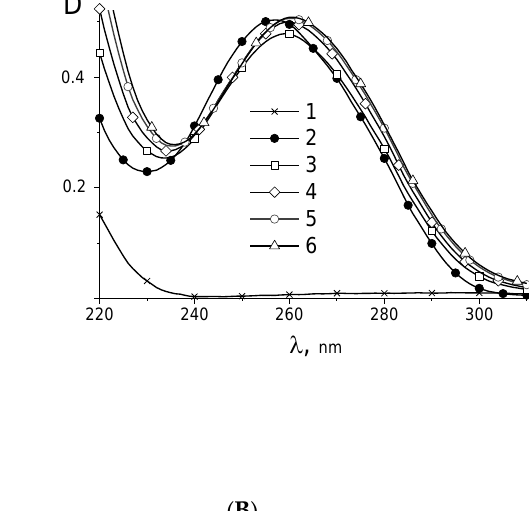
Figure 2. ( A ) Calculated DNA absorption spectra in complexes with Pt2 in 0.005 M NaCl ( A ) at C(Pt2) × 10 5 = 0 (1), 1.5 (2), 3.4 (3), 4.9 (4), 6.4 (5) and spectrum of Pt2 without DNA at C(Pt2) = 3.42 × 10 − 5 (6), C(DNA) = 0.0024% =7.2 × 10 − 5 M (P); ( B ) absorption spectra of DNA in DNA-cis-DDP complexes C(Pt) × 10 5 = 0 (2), 1.2 (3). 2.2 (4), 3.9 (5), 5.6 (6). Spectrum for cis-DDP (1) was registered at C(Pt) =3.9 × 10 − 5